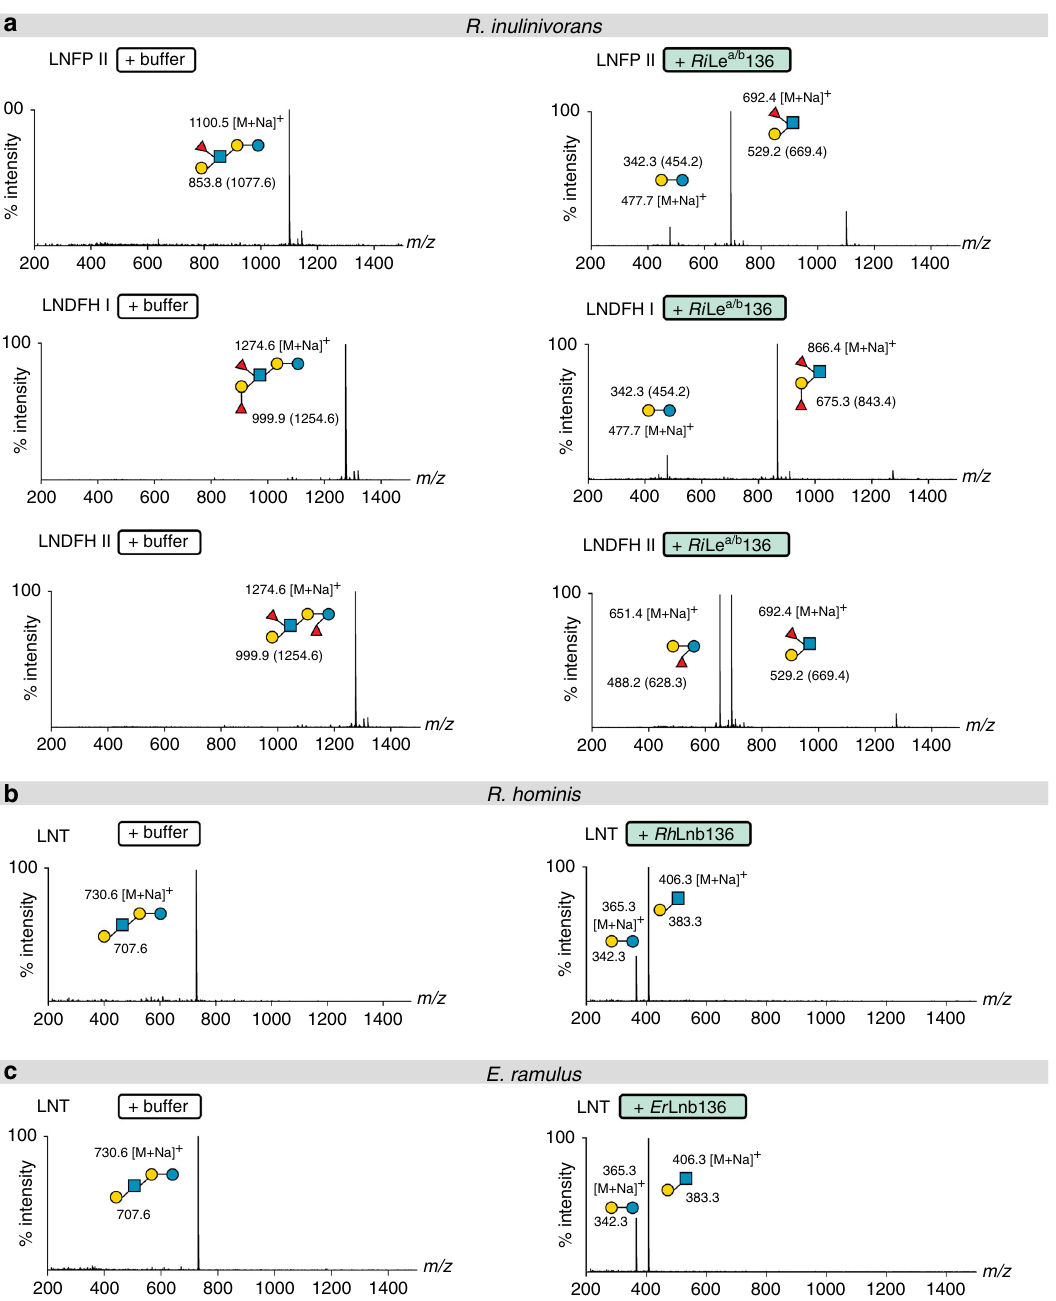
Fig. 2 Speci fi cities of GH136 enzymes that mediate the HMO degradation. a Activity of Ri Le a/b 136 on fucosylated HMOs. b Activity of Rh Lnb136 on LNT. c Activity of Er Lnb136 on LNT. a – c The hydrolysates were analysed by MALDI-ToF MS without ( b , c ) or with a permethylation. a Masses of methylated sugars are in parentheses and the ion peaks correspond to the Na + adducts of the methylated sugars. a – c relative intensity (percentage intensity) is shown. The MALDI-ToF MS analyses ( a – c ) were performed from independent triplicates (one analysis from each biological enzymatic reaction replicate) and all analyses yielded similar